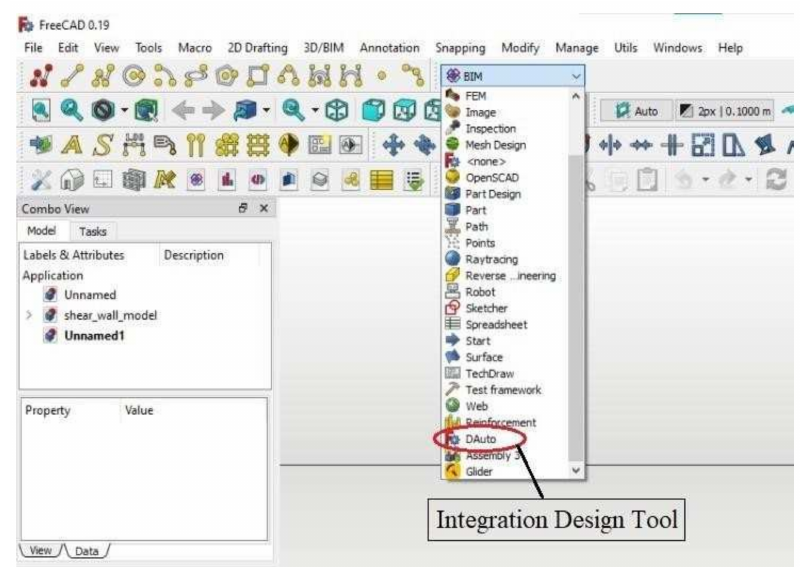
Figure 8. Graphical user interface of the